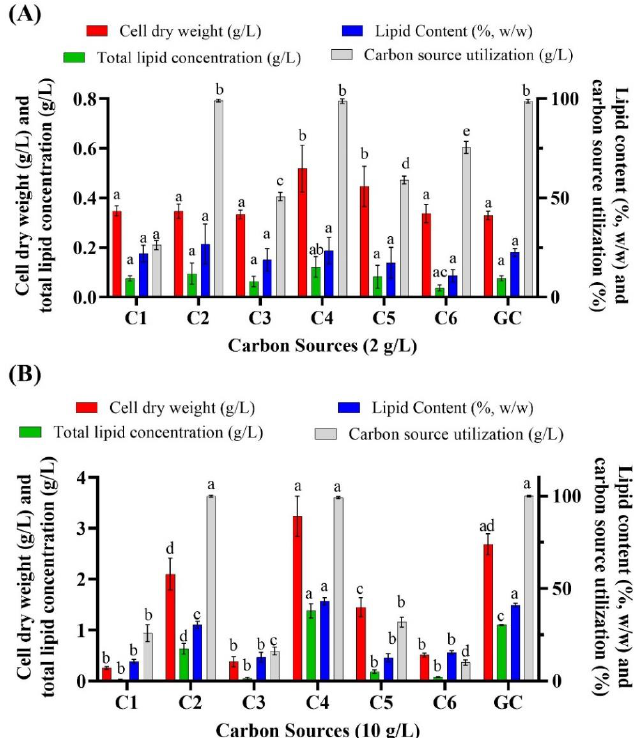
Figure 1. Batch cultivation of Aurantiochytrium sp. T66 on various volatile fatty acids (VFAs) at 2 g/L ( A ) and 10 g/L ( B ). Glucose (GC) was used as control. Error bars express the standard deviation of the mean ( n = 3). Different letters (a,b,c,d,e) above the bars in each group of results indicate significant difference ( p < 0.05), based on one-way ANOVA with Tukey ’ s test.